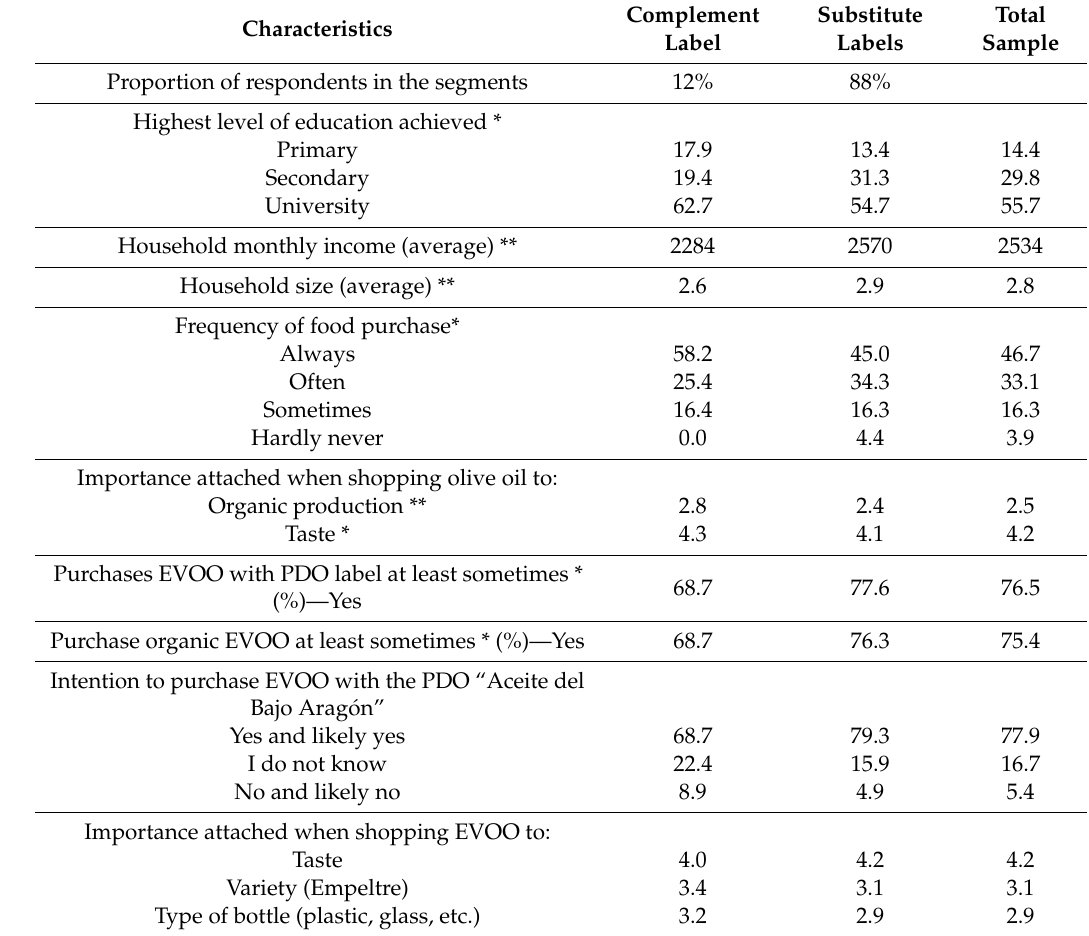
Table 5. Characterization of consumers’